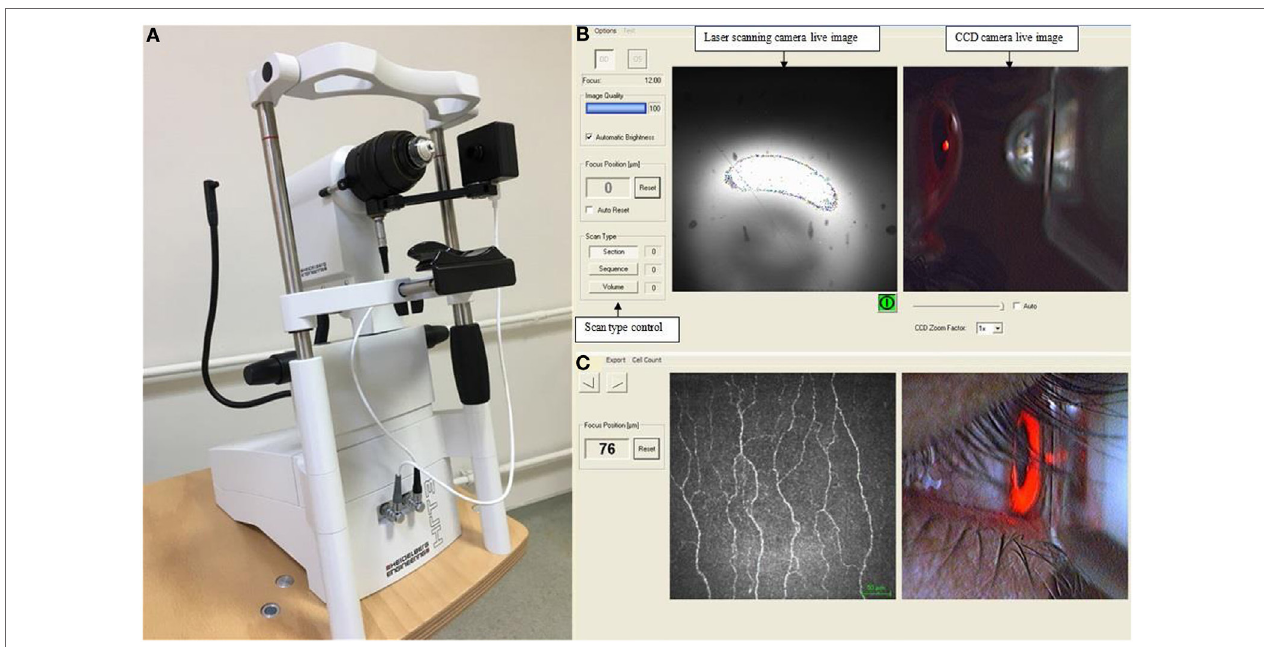
FigUre 1 | Corneal confocal microscope (a) , the viewing screen on monitor during image acquisition (B) , and a captured image of the sub-basal nerve plexus using the section mode (c)